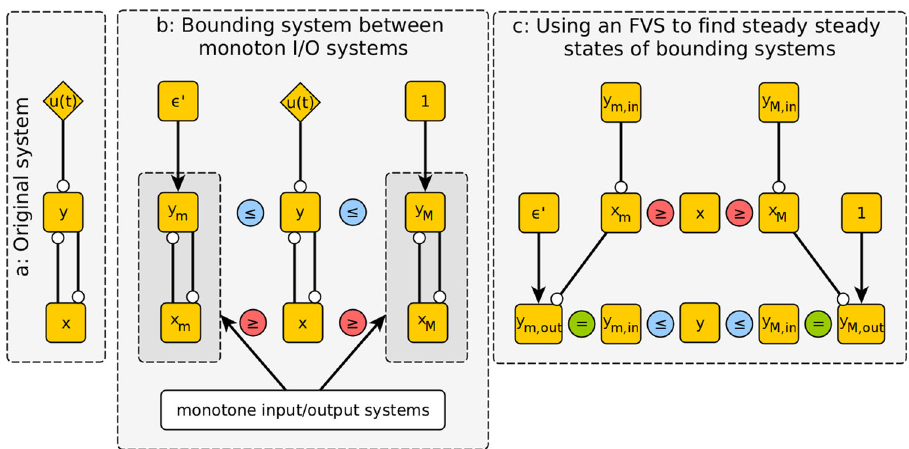
Fig. 2 Schematic of stable motif procedure applied to the system of Eq. 6. The network structure of the system is depicted in panel a . Circle-tipped arrows represent inhibition, while wedge-tipped arrows represent activation. In panel b , the bounding systems in Eqs. 8 and 9 are depicted alongside the original system. Note that these bounding systems are monotone input/output systems. Panel c illustrates the characteristic feedback method of identifying steady states in monotone input/output systems, wherein the effect of overriding a feedback vertex set (FVS), in this case, the set containing y m or y M , is considered, as described in the example of Eq.